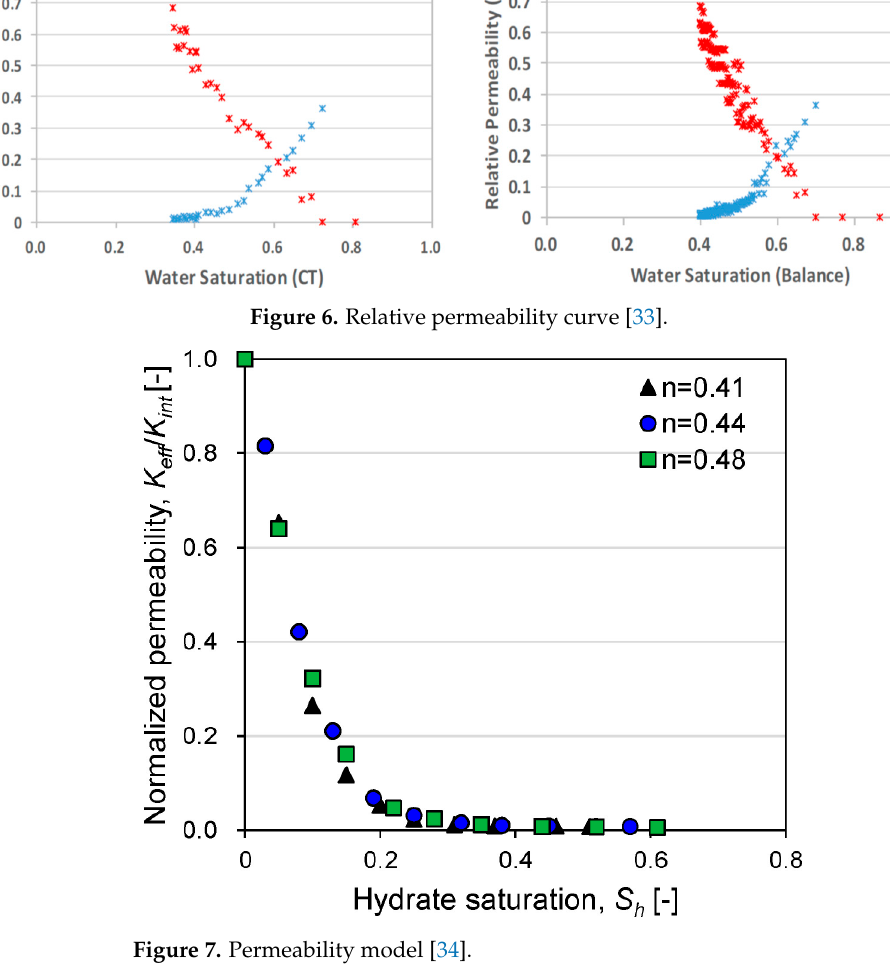
Figure 7. Permeability model [34].